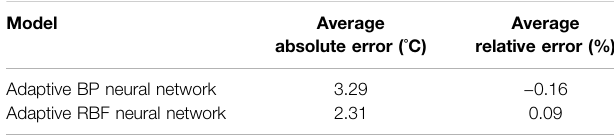
TABLE 4 | Average error results calculated by different